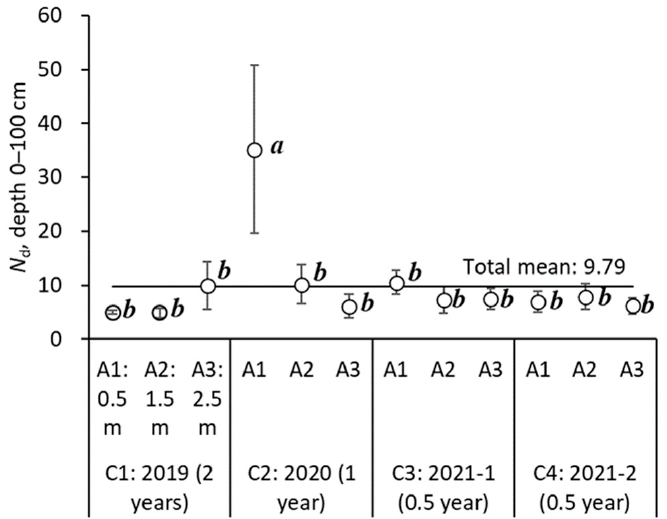
Figure 12. Interaction of Factor A (relative position) and Factor C (fiscal year of construction) of Site 2 on the N d —value. The error bars and different letters have the same meaning as in Figure 9. p < 0.01, n = 8.